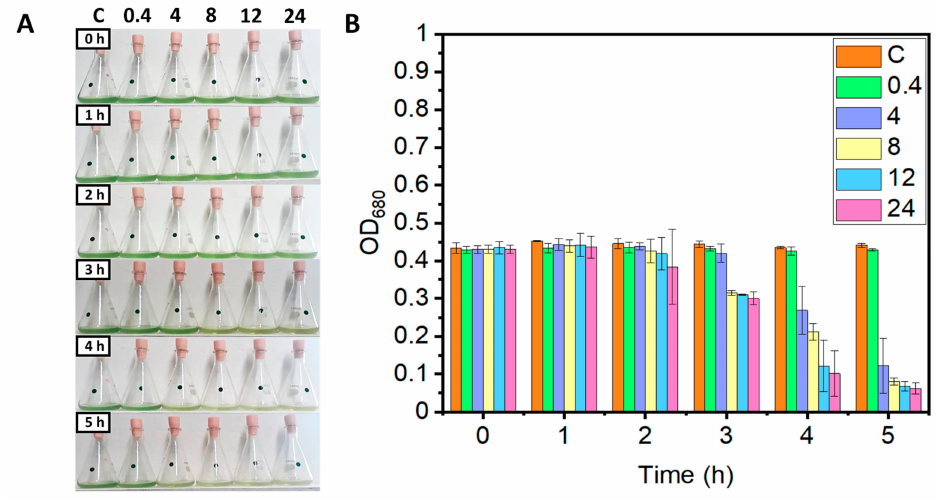
Figure 7. Growth inhibition of Microcystis aeruginosa by Cu-VO with time. ( A ) Change in the pigment of M. aeruginosa suspension; ( B ) change in OD 680 of M. aeruginosa . C was a control group containing M. aeruginosa alone. The antialgal assay was performed three times, and the OD 680 plot is the average of three independent results.